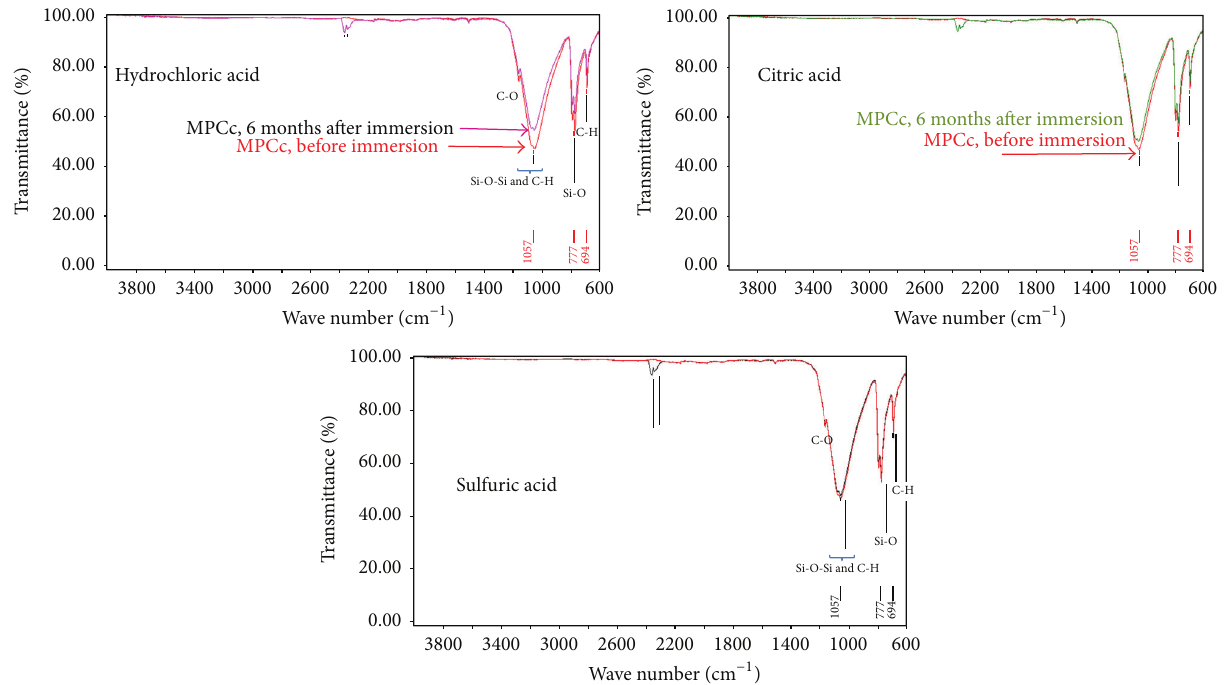
Figure 13: FTIR spectra of micropolymer concrete MPCc before and after 6 months of exposure to different selected acid solutions.